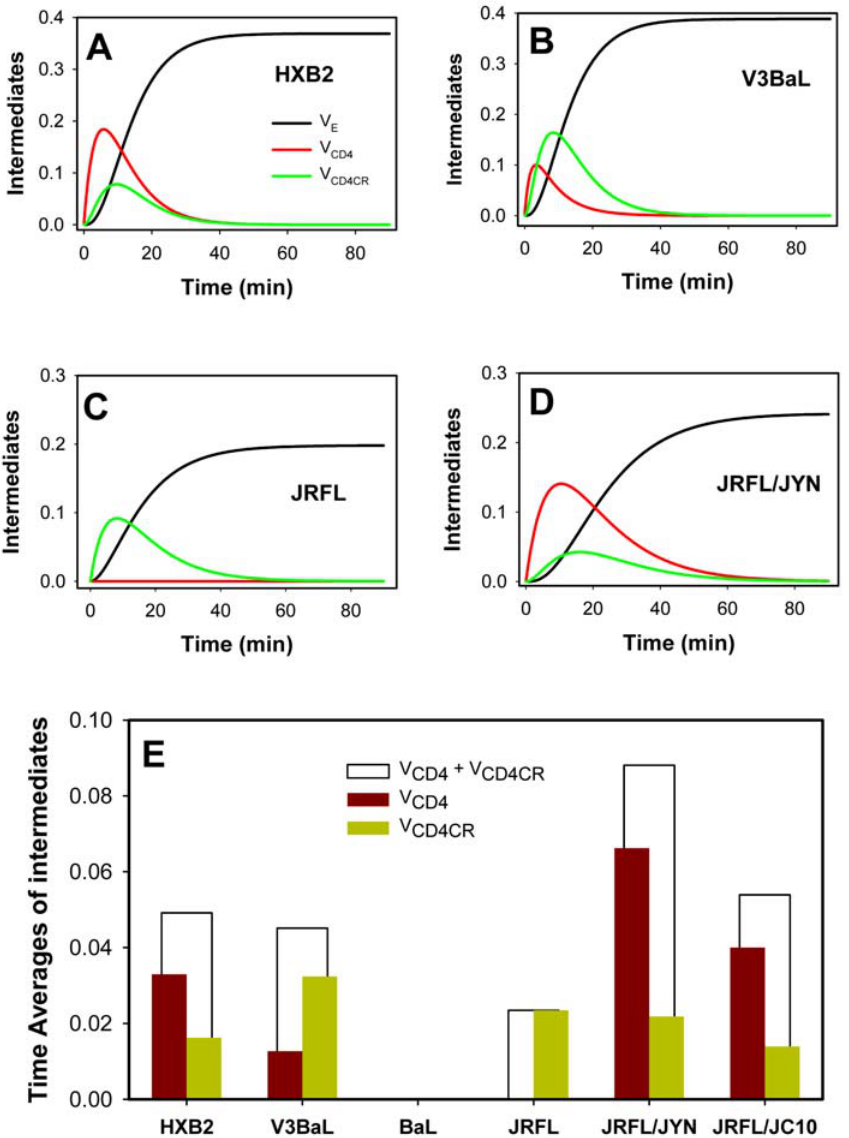
Figure 4. Kinetics of HIV-1 progression through intermediate states and the residence times in these states. (A–D) The probabilities of finding the virus in CD4-bound (V CD4 ) and coreceptor-bound (V CD4CR ) states and of undergoing receptor-mediated endocytosis (V E ) as a function of time were obtained by entering the respective rate constants (Table 1) into the equations (6–8). (E) Time averages for HIV-1 in the CD4-bound and coreceptor-bound states were determined from equations (13) and (14), using the respective rate constants. The total time averages of HIV-1 in intermediate stages prior to undergoing endocytosis (the sum of V CD4 and V CD4CR ) are shown by open bars.